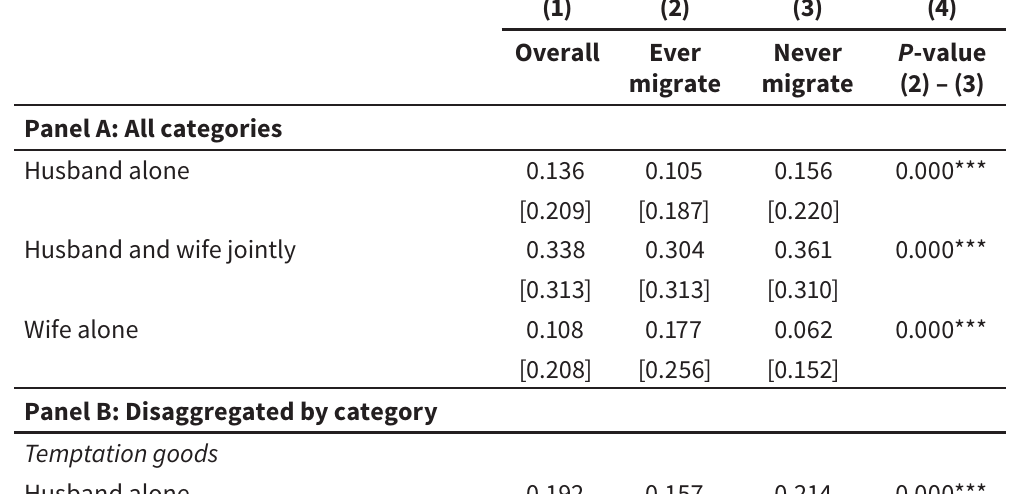
Decision-making outcomes by migrant